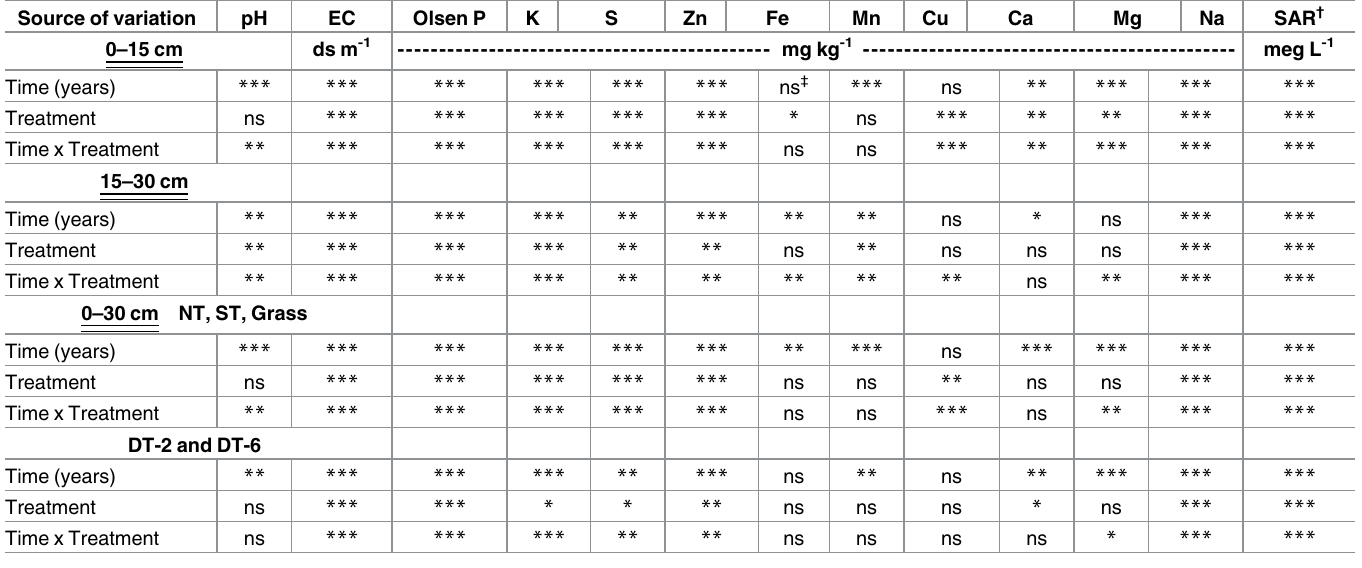
Table 7. Statistical significance of the main and interaction effectsof different treatment combinations and sampling time (years) on soil chemical properties at 0–15, 15–30, and 0–30 cm depth from 2006 to 2012sampling dates. Source of variation